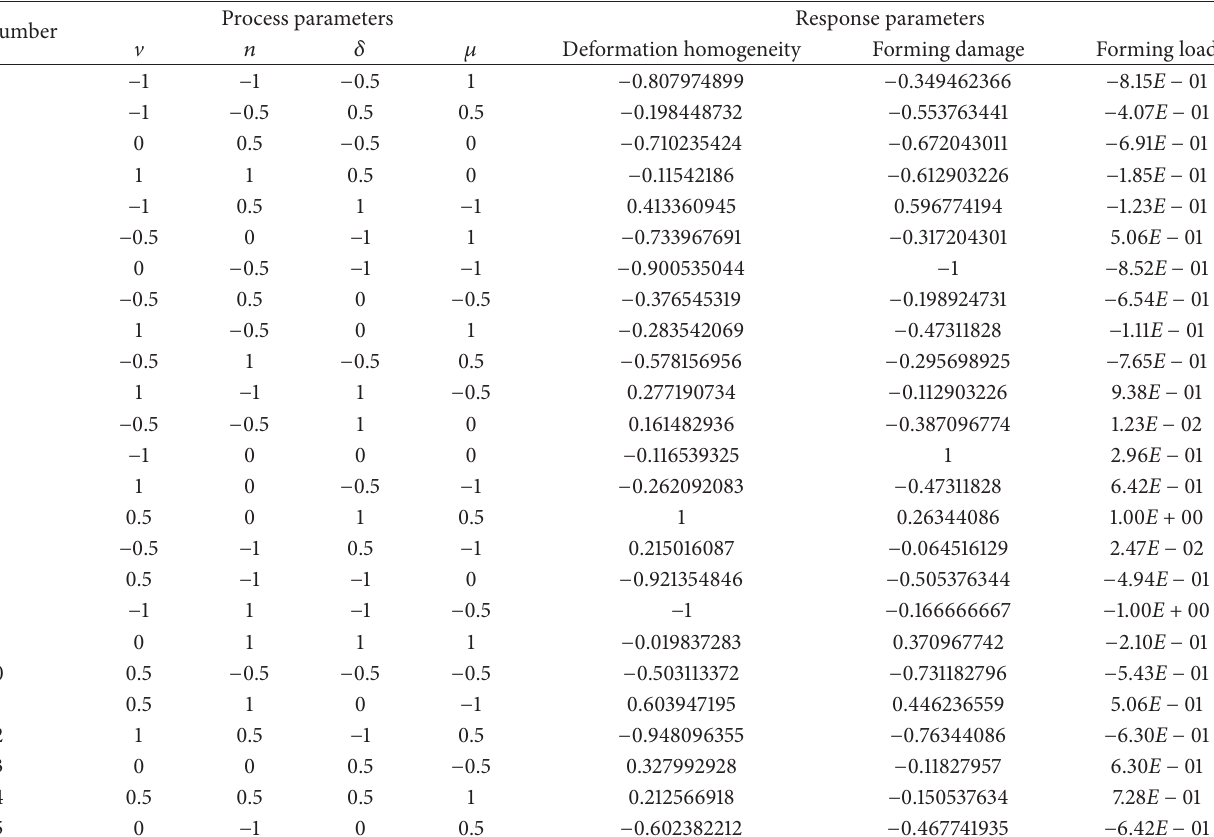
Table 1: Latin hypercube experiment